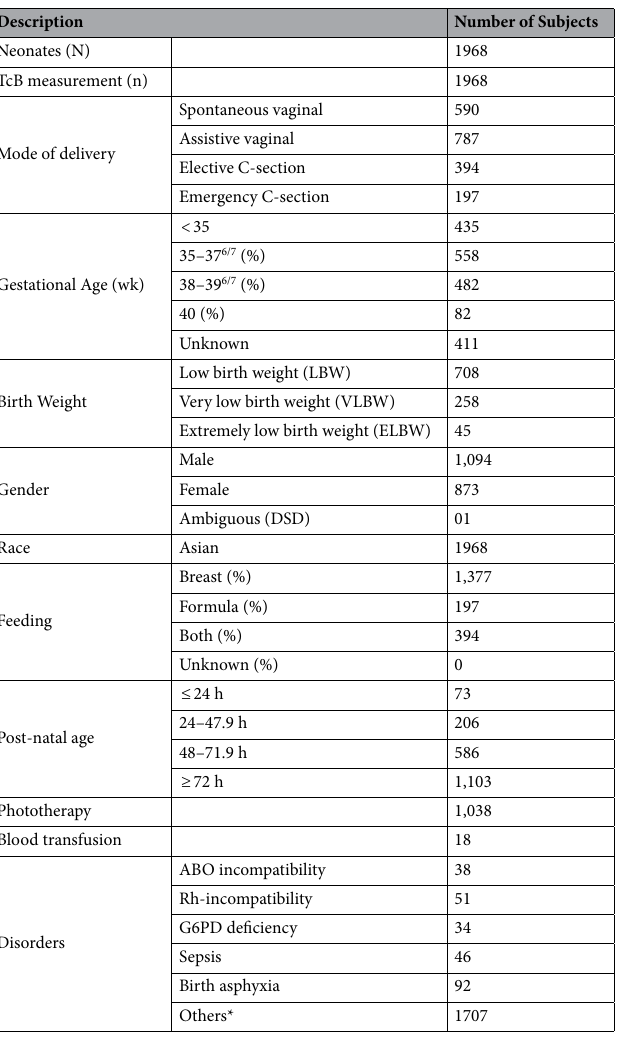
Table 1. Demographic details of the new-born subjects participated in the study. *Other disorders include maternal varicella, hypoglycaemia, jitteriness, sclerema, premature rupture of the membranes (PROM), apnoea of prematurity, intrauterine growth-retarded (IUGR), late-onset neonatal sepsis (LONS), gastric duplication cyst, pneumonia on mv, polycythaemia, hepatosplenomegaly, torch (+ Ve, HSV, CMV), congenital rubella, rubella (IgM +), neonatal convulsion, hyperthermia, laboured breathing, hypothyroid, osteogenesis imperfect, meningitis, congenital anomaly, Pierre Robin syndrome, chorioamnionitis, and mother